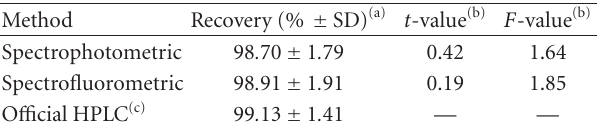
Table 5: Analysis of AMD in capsules by the proposed and o ffi cial